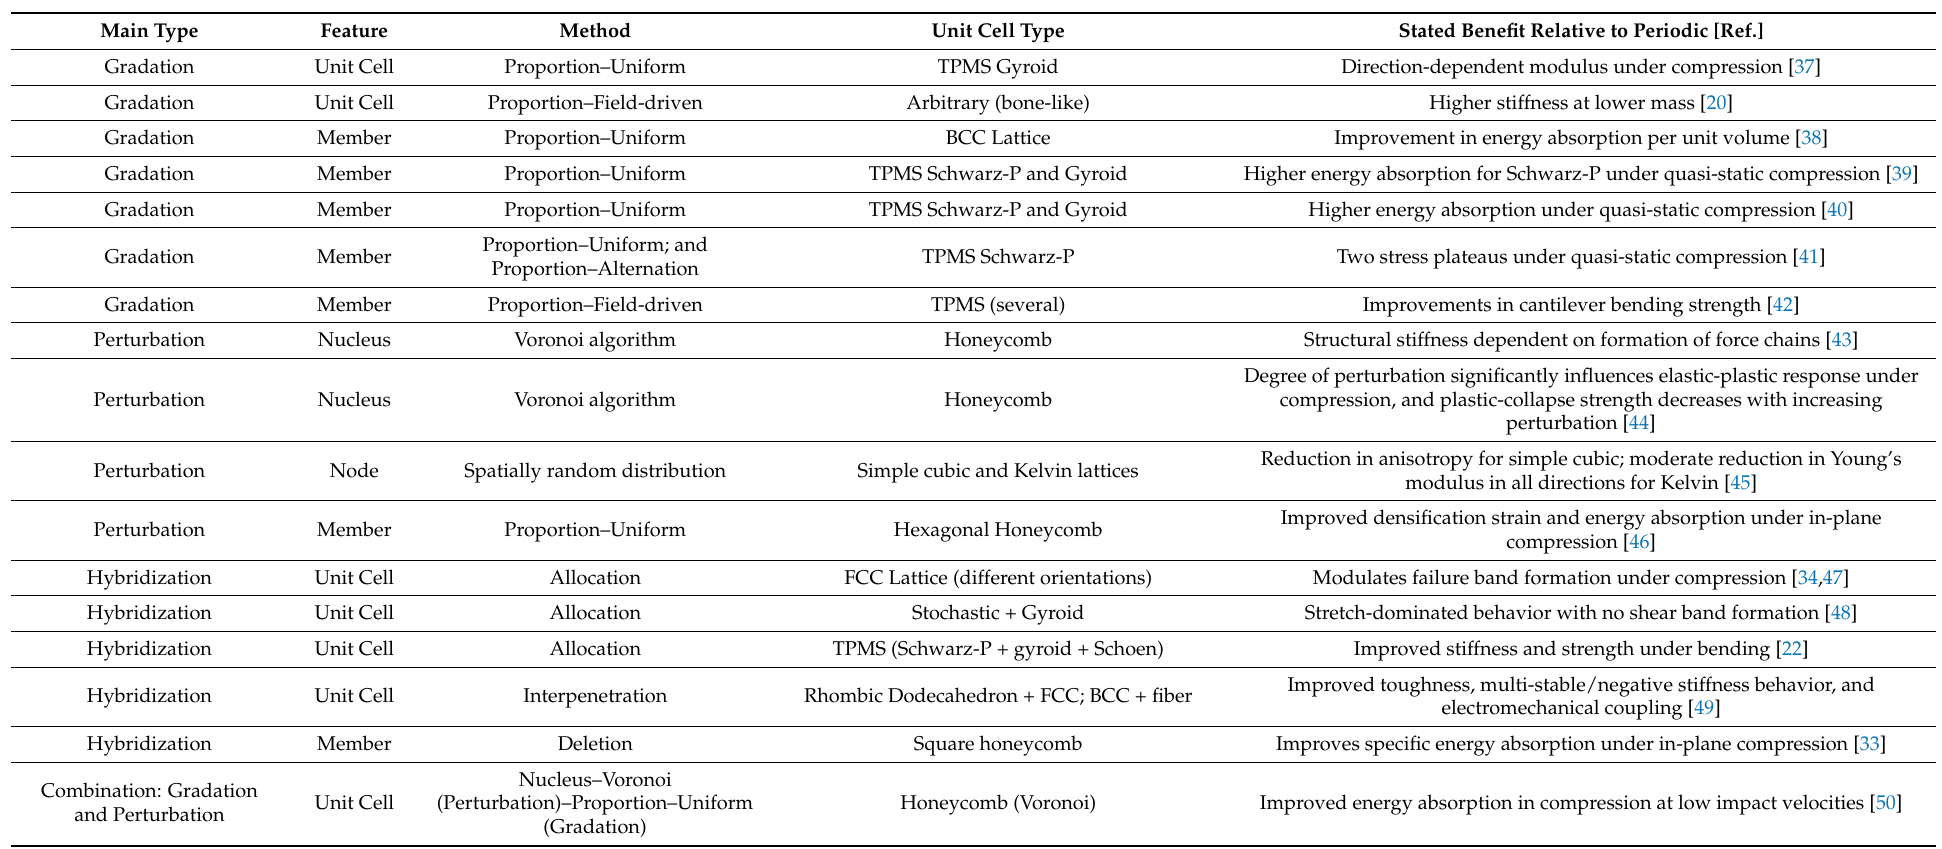
Table 1. Summary of select studies on the behavior of aperiodic architected cellular